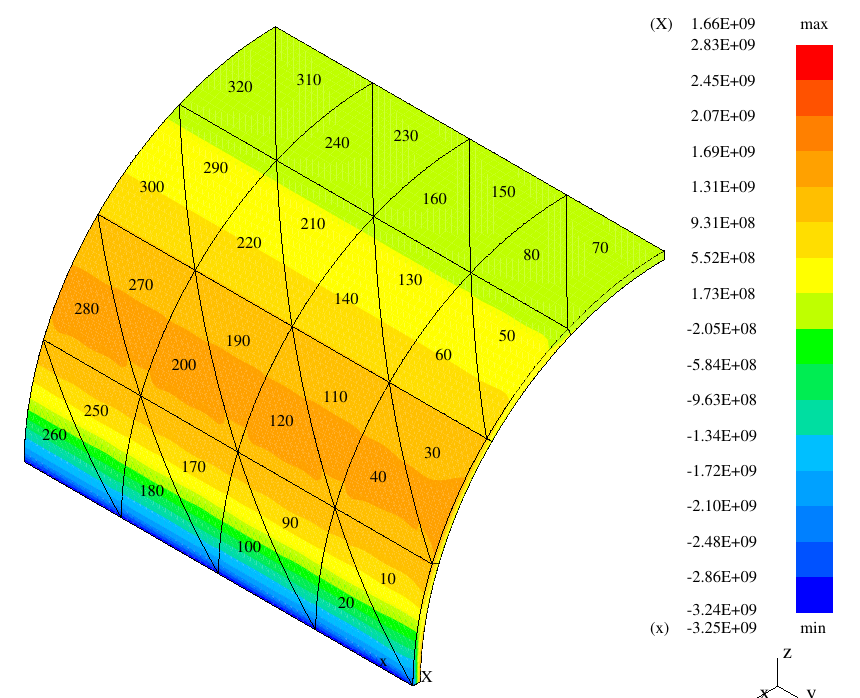
Figure 16. Third normal stress—the bent shell with the enhanced transition elements.